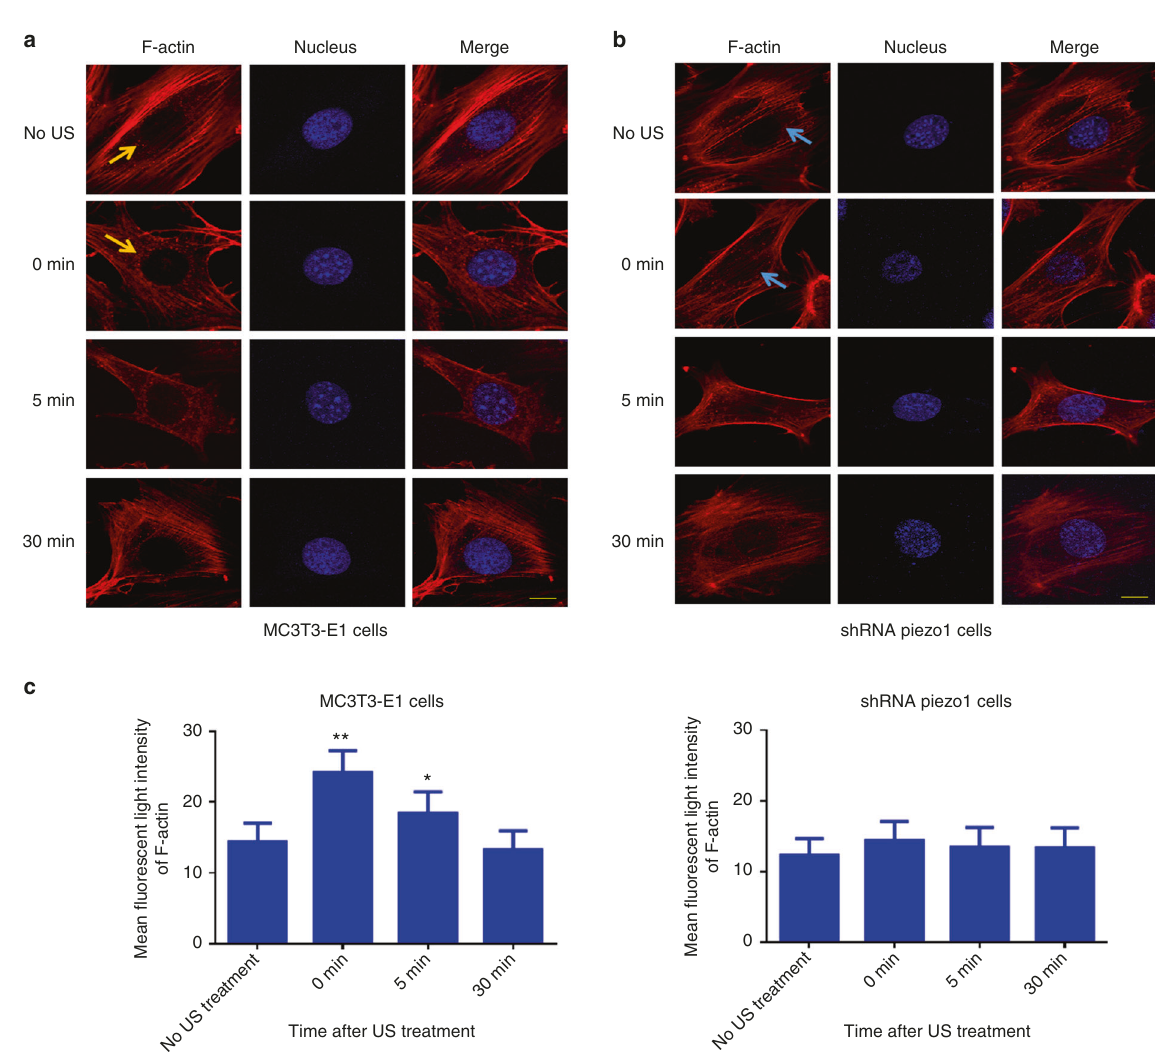
Fig. 5 Polymerization of perinuclear F-actin after LIPUS stimulation. a , b Representative fl uorescence images of Phalloidin-iFluor-labeled F-actin around the nuclei in MC3T3-E1 and shRNA-Piezo1 cells. The orange arrows in a and blue arrows in b indicate perinuclear F-actin. Scale bars: 10 μ m. c The mean fl uorescence intensity of perinuclear F-actin was measured and analyzed with ImageJ at the indicated time points (0, 5, and 30 min) after LIPUS stimulation ( n = 9, * P < 0.05, ** P < 0.01, Student ’ s t